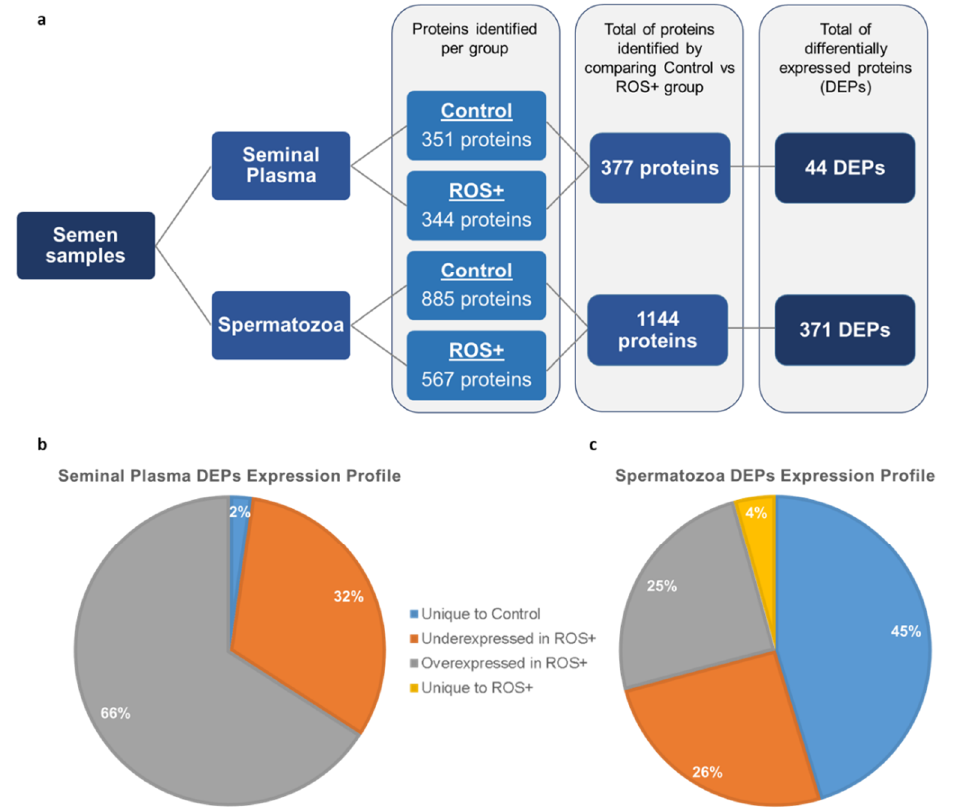
Figure 1. Schematic representation of the results obtained by proteomic analysis: ( a ) number of proteins identified in the seminal plasma and spermatozoa of fertile men (control) and men with high levels of reactive oxygen species (ROS+), as well as the number of differentially expressed proteins (DEPs) between the experimental groups; ( b ) expression profile of seminal plasma DEPs; and ( c ) expression profile of spermatozoa DEPs.